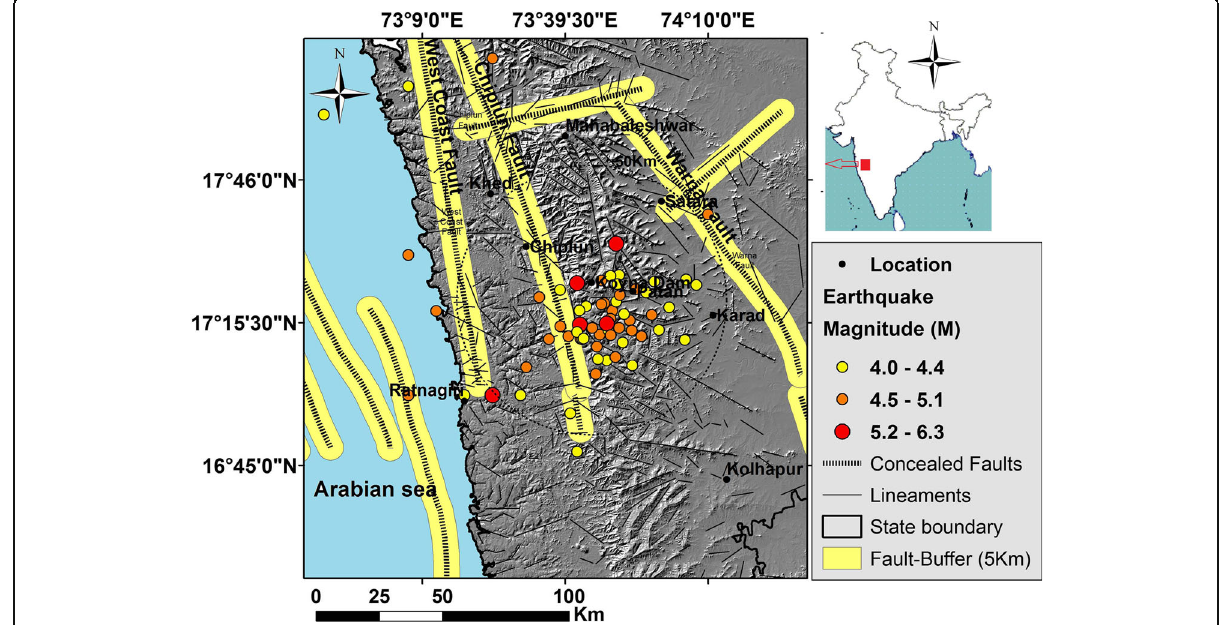
Fig. 6 Seismic events, concealed faults and